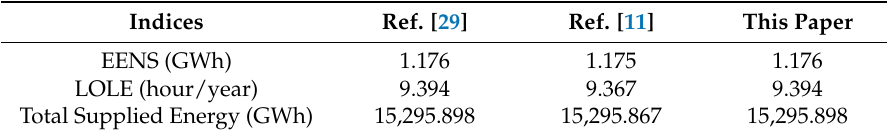
Table 3. Comparison on simulation results without wind